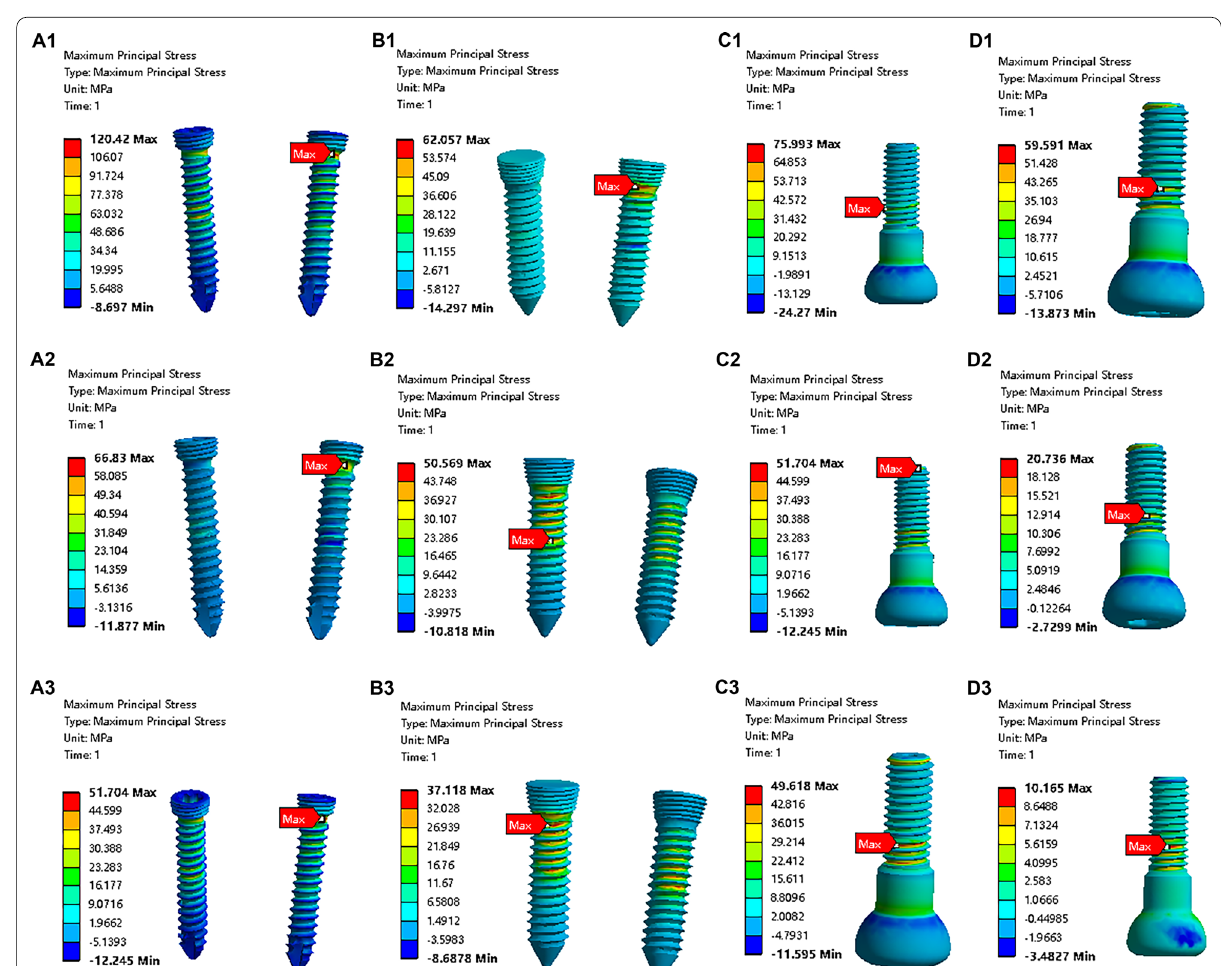
Fig. 4 The stress distribution on the fixation bolt. A1 The stress distribution on the fixation bolts when using a double 2.0‑mm bolt at 30° elbow flexion. A2 . The stress distribution on the fixation bolts when using a double 2.0‑mm bolt at 90° elbow flexion. A3 The stress distribution on the fixation bolts when using a double 2.0‑mm bolt at 130° elbow flexion. B1 The stress distribution on the fixation bolts when using a double 2.5‑mm bolt at 30° elbow flexion. B2 The stress distribution on the fixation bolts when using a double 2.5‑mm bolt at 90° elbow flexion. B3 . The stress distribution on the fixation bolts when using a double 2.5‑mm bolt at 130° elbow flexion. C1 The stress distribution on the fixation bolt when using a single 4.0‑mm bolt at 30° elbow flexion. C2 The stress distribution on the fixation bolt when using a single 4.0‑mm bolt at 90° elbow flexion. C3 The stress distribution on the fixation bolt when using a single 4.0‑mm bolt at 130° elbow flexion. D1 The stress distribution on the fixation bolt when using a single 4.5‑mm bolt at 30° elbow flexion. D2 The stress distribution on the fixation bolt when using a single 4.5‑mm bolt at 90° elbow flexion. D3 The stress distribution on the fixation bolt when using a single 4.5‑mm bolt at 130° elbow